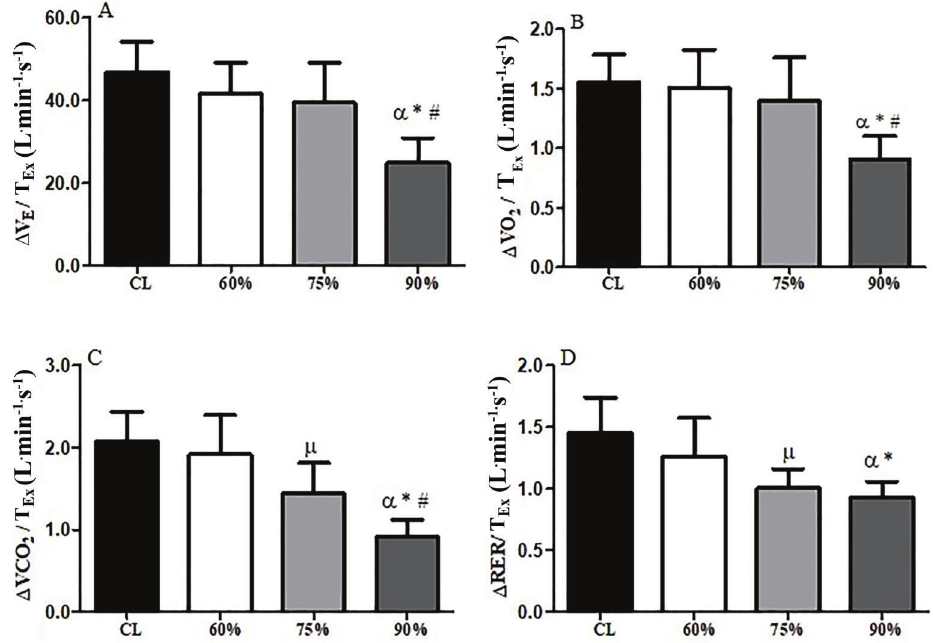
Figure 5. A , Minute ventilation variability ( D V E ), B , oxygen uptake variability ( D VO 2 ), C , carbon dioxide production variability ( D VCO 2 ), and D , respiratory exchange ratio variability ( D RER) corrected to time to exhaustion (T Ex ) at different intensities as well as on critical load (CL). Data are reported means ± SD. a P o 0.05 compared to CL; *P o 0.05 compared to 60%; # P o 0.05 compared to 75%; m P o 0.05 compared to CL